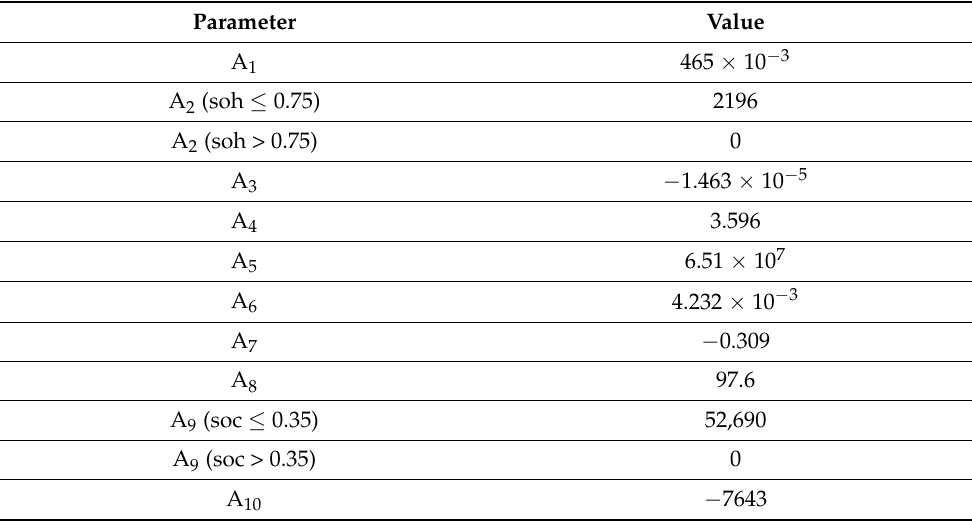
Table 2. Table 2. Parameter values of Rint model for 20 Ah Lithium-ion (LiFePO 4 )